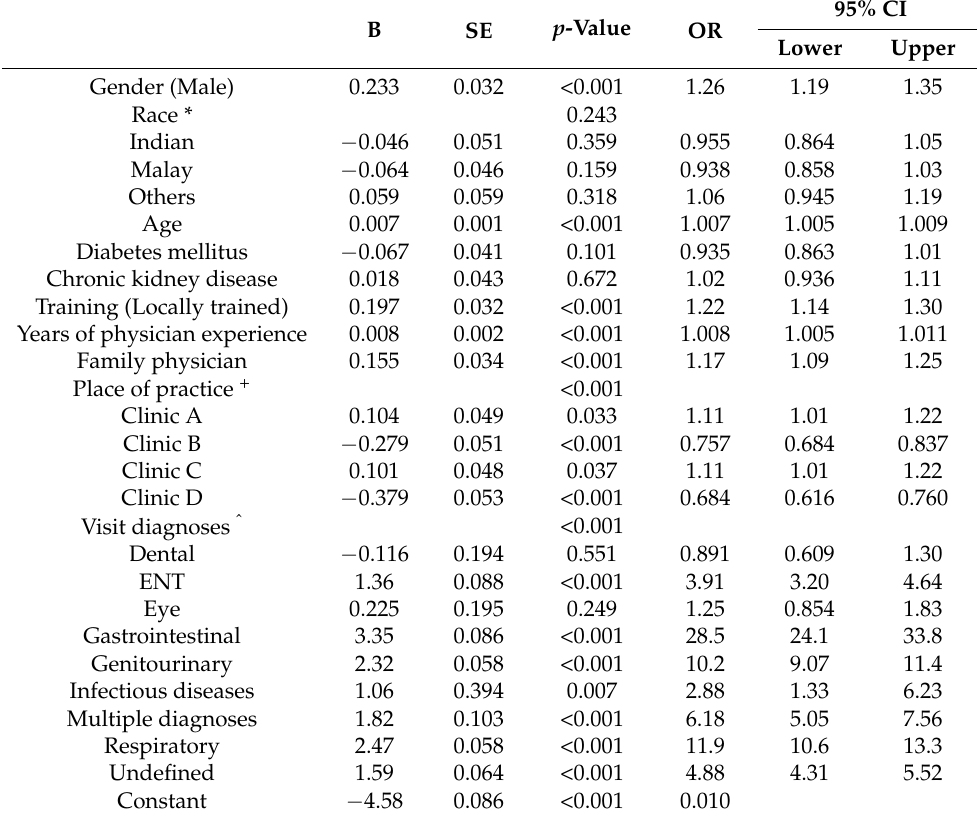
Table A3. Multivariate logistic regression for factors contributing to Watch group antibiotic prescrip- tions,